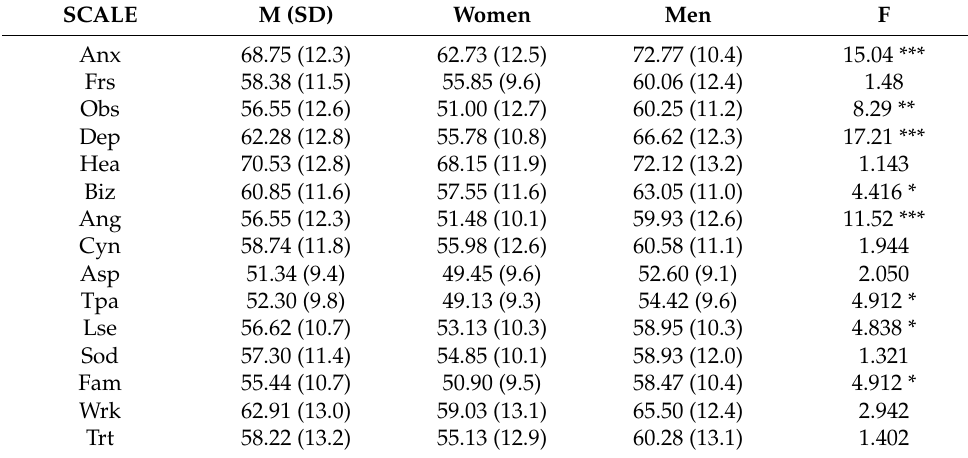
Figure 2. Gender differences in Minnesota Multiphasic Personality Inventory—2, MMPI-2 content scales (Mean T score). * significant differences of at least p < 0.05. Table 3. Descriptive statistics of Minnesota Multiphasic Personality Inventory—2, MMPI-2 content scales and gender differences.